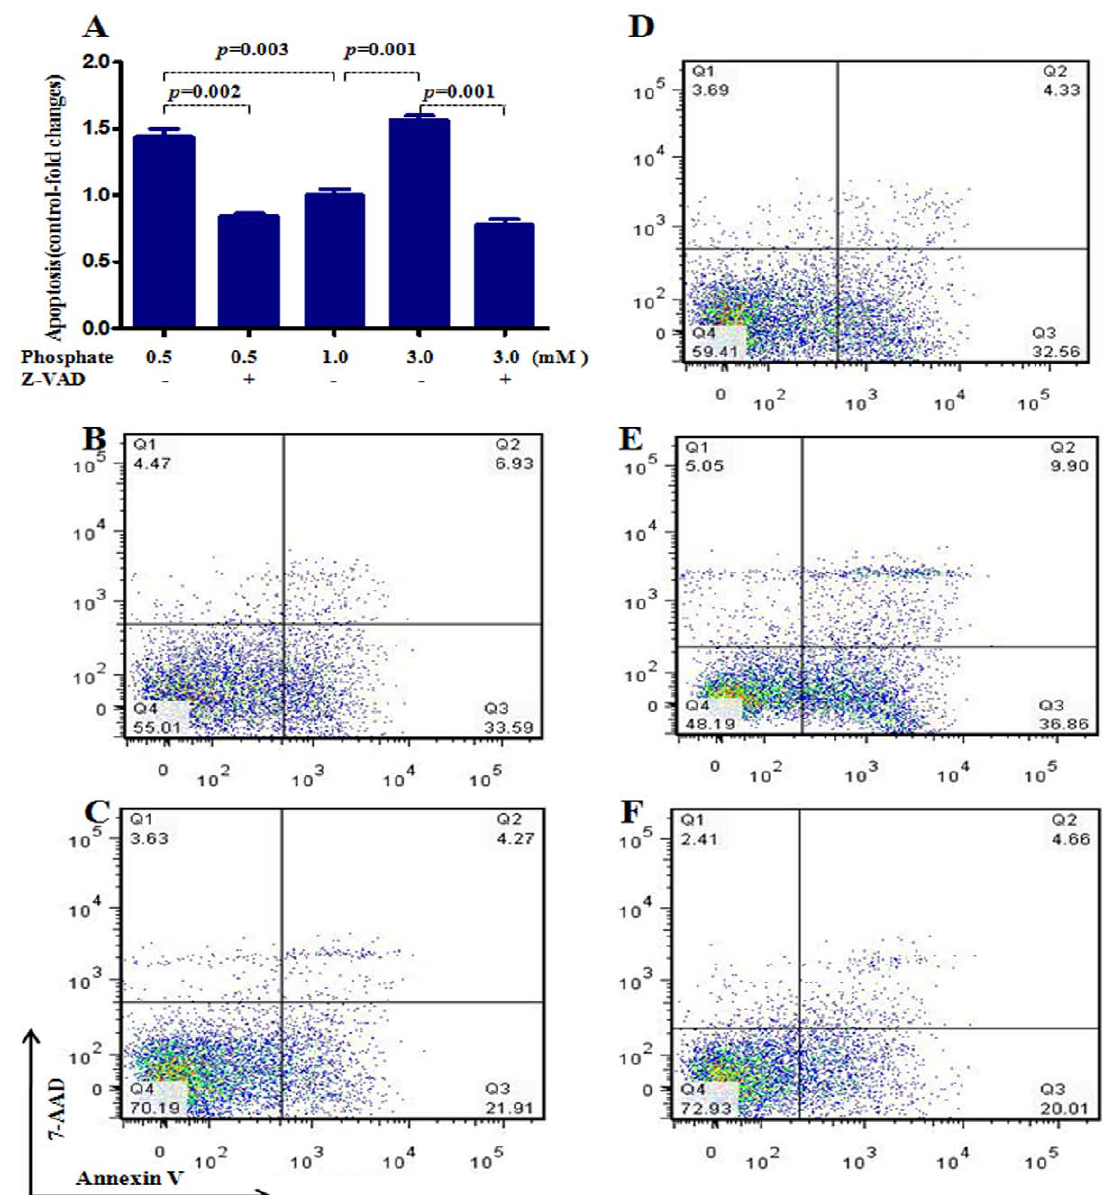
Figure 2. Effect of pan-caspase inhibitor z-VAD in preventing apoptosis caused by simulated hypophosphatemia and hyperphosphatemia. To further define the role of inorganic phosphate on human umbilical vein endothelial cell apoptosis, a pan-caspase inhibitor z-VAD (40 uM) was added to the medium containing various concentrations of phosphate. Incubation with pan-caspase inhibitor z-VAD prevented apoptosis induced by both simulated hyperphosphatemia and hypophosphatemia (Figure 2 A–F). B: hypophosphatemia (0.5 mM); C: hypophosphatemia (0.5 mM) plus z-VAD; D: phosphate (1 mM); E: hyperphosphatemia (3 mM phosphate); F: hyperphosphatemia (3 mM) plus z-VAD. In Figure B–F, data in each quadrant are the percentage of total cells, and shown as mean + / 2 SEM. p values vs control (1 mM phosphate). N=6 ,